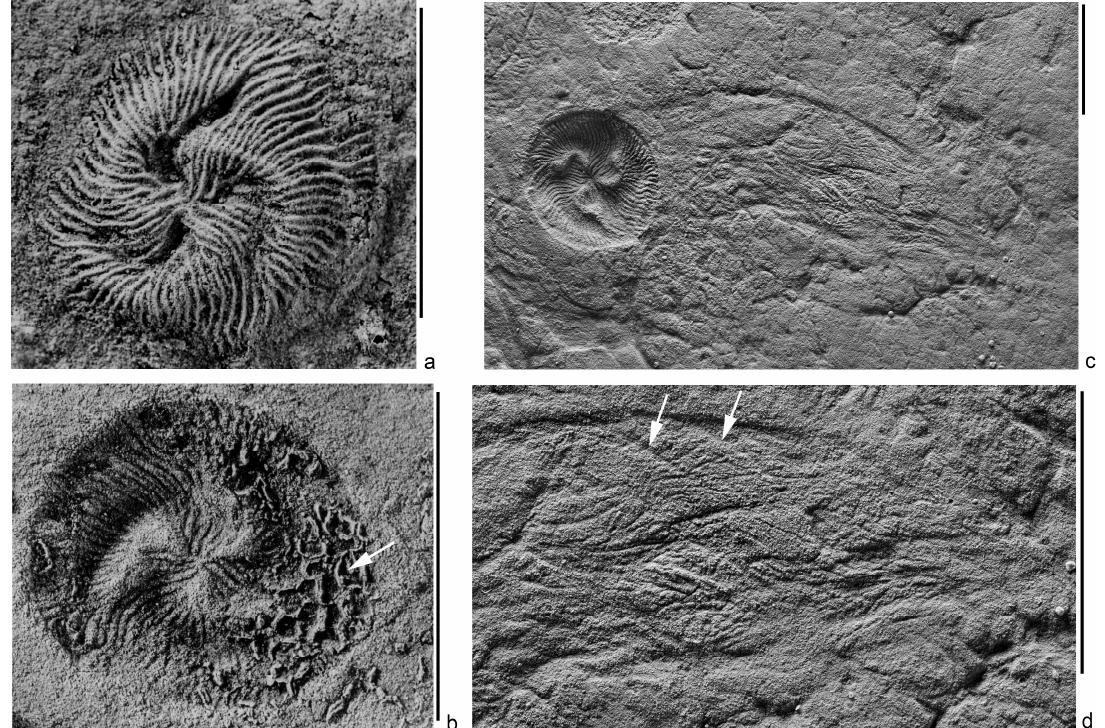
Figure 3. Tribrachidium heraldicum Glaessner, 1959, southeastern White Sea region, Zimnie Gory locality, burial Z1(I) “Kimberella lenses”, scale bars are 1 cm: ( a )—the central part of the shield, spec. PIN, no. 3993 / 6416, latex cast from a natural imprint; ( b – d )—natural imprints (( b )—body imprint with a superimposed fragment of the paleopascichnid buildup (arrow), in which chambers were partially destroyed, spec. PIN, no. 3993 / 6504; ( c )—trace extending from the shield, spec. PIN, no. 3993 / 8400; ( d )—fragment with high magnification, arrows indicate grooves (represented by ridges on the initial trace), which, perhaps, were left by the margin of the shield as a result of temporary stops of the progressive movement of the